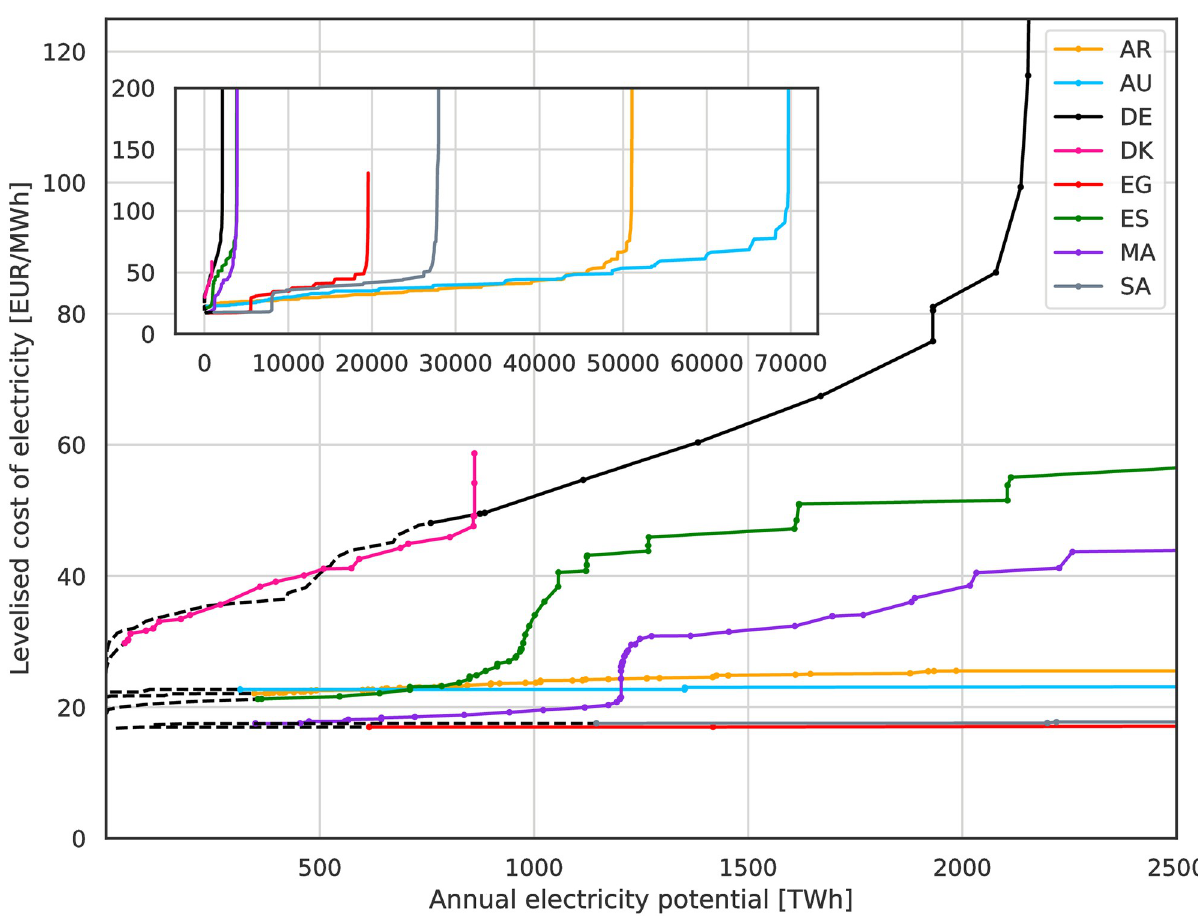
Fig 3. Modelled electricity supply curves for 2030 at 10% p.a. WACC. Dashed black parts are reserved for meeting domestic electricity demand and unavailable for export. The inlet contains the same plot on a larger scale. The visible step-wise increase in LCoE for ES and MA is where the cheapest electricity potentials from low cost PV are exhausted and the onshore and offshore wind enter the supply curve.